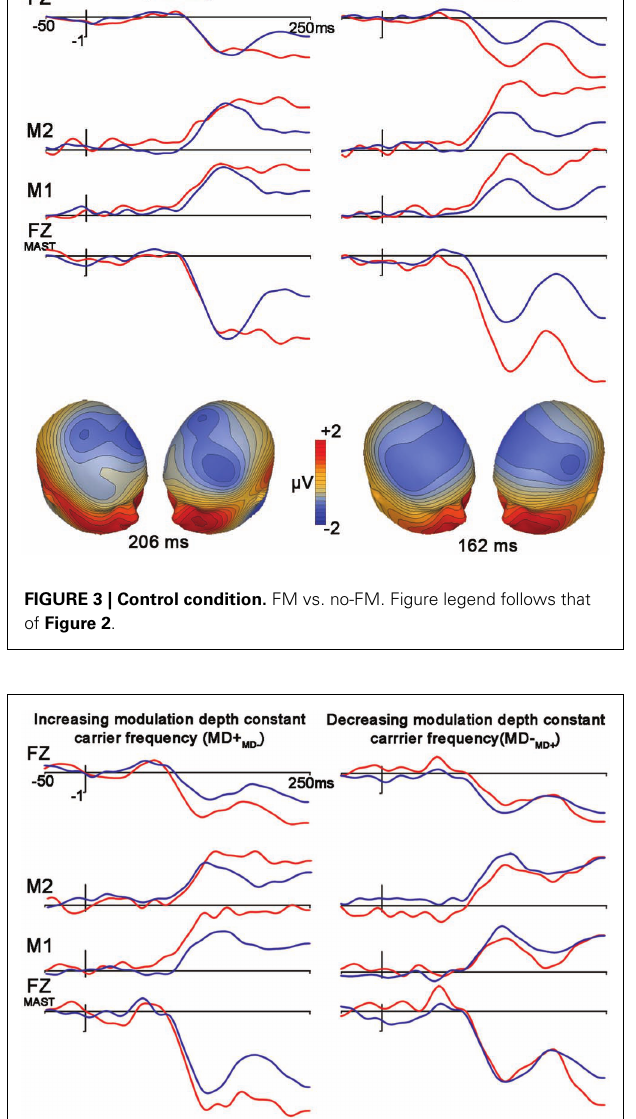
Figure 5 indicates, subjects endorsed each tone differently. High carrier frequency and high modulation depth (378, 169 Hz) was identified as happy by 84.6% of subjects. The no-FM tone (378 no-FM) was identified as neutral by 92.3% of subjects. Finally, the majority of subjects recognized tones with high (378 Hz) and